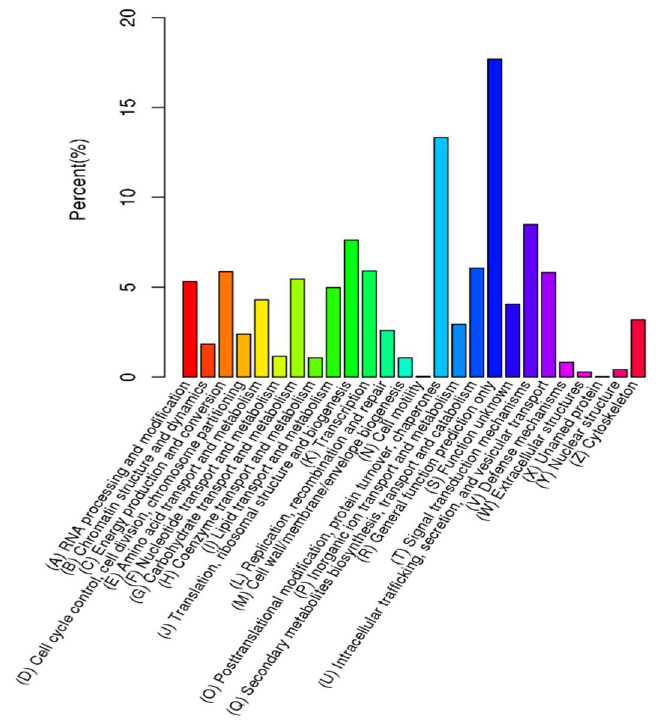
Figure 3. KOG classification of assembled unigenes of the L. yunnanensis flower transcriptome. The x -axis indicates the 26 groups in KOG annotation; the y -axis indicates the percentage of the number of genes in each group relative to the total number of annotated genes.